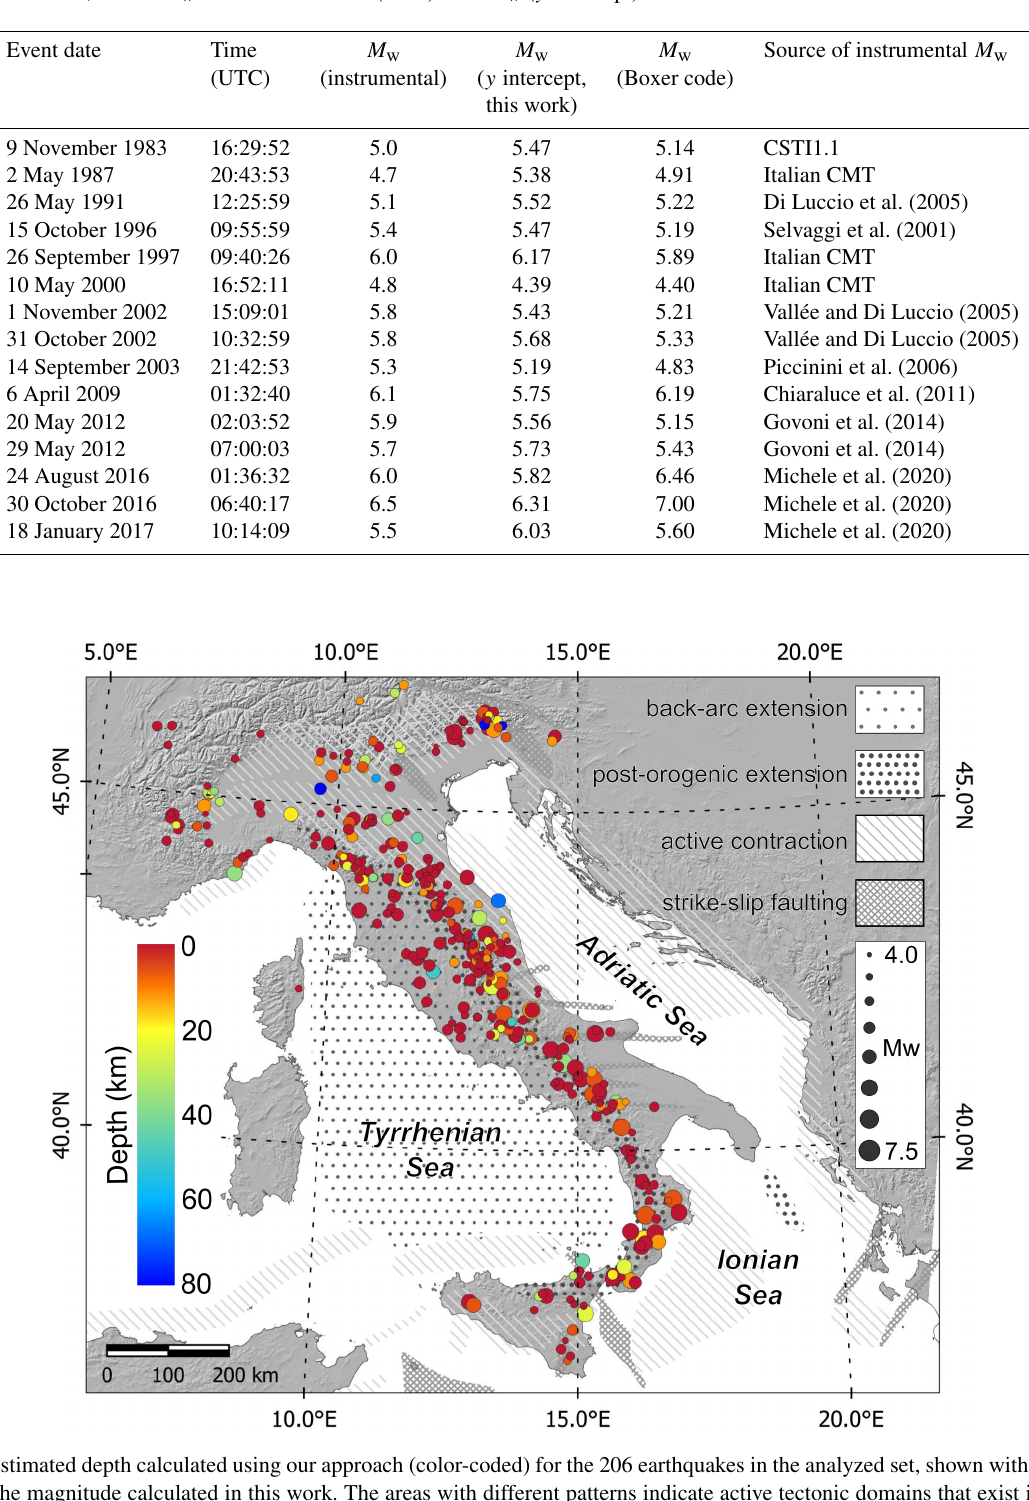
Table 2. Comparison of M w estimates. The source of M w (Boxer code) is the CPTI15 v2.0 catalogue (Rovida et al., 2019), with the exception of the last three events, whose M w is from Rossi et al. (2019). The M w ( y intercept) is from this work.